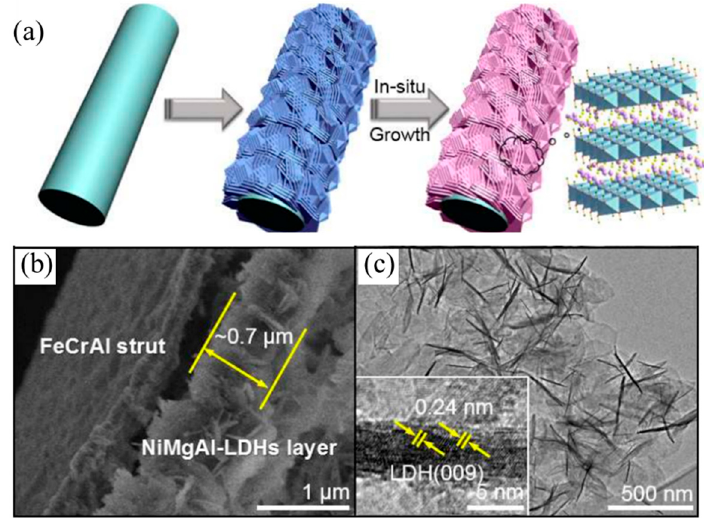
Figure 6. ( a ) Schematic of microfibrous-structured NiO-MgO-Al 2 O 3 nano-sheets grown on FeCrAl-fiber felt and ( b ) SEM image and ( c ) TEM image of NiMgAl-LDHs/FeCrAl-fiber-900 [82].